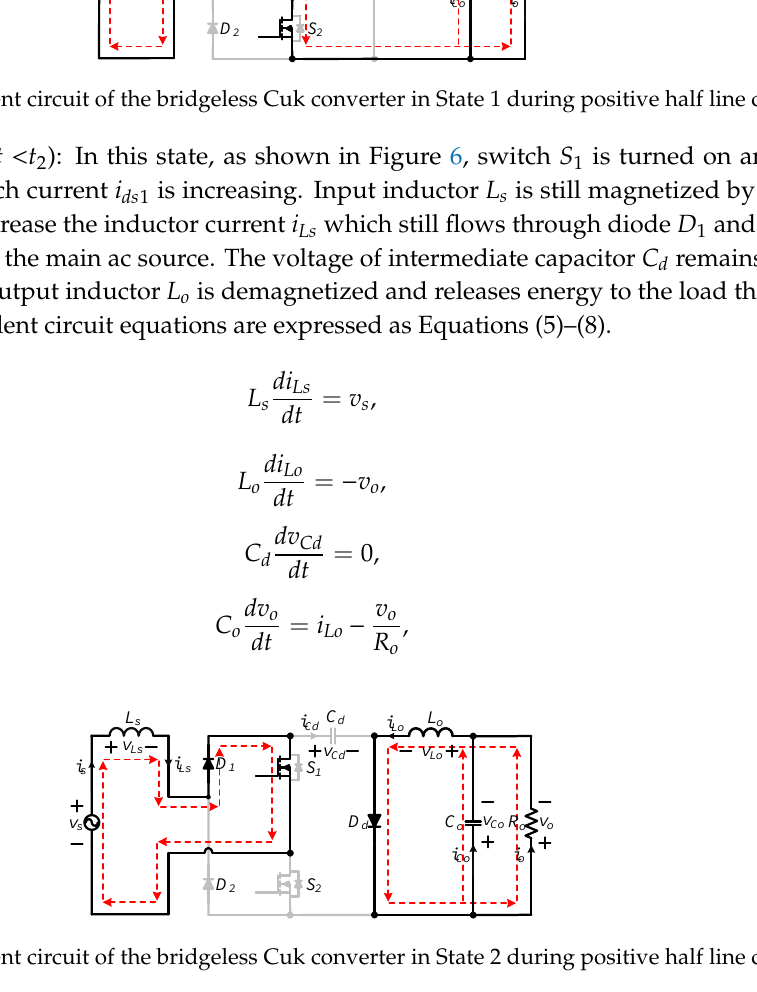
Figure 5. Equivalent circuit of the bridgeless Cuk converter in State 1 during positive half line cycle.